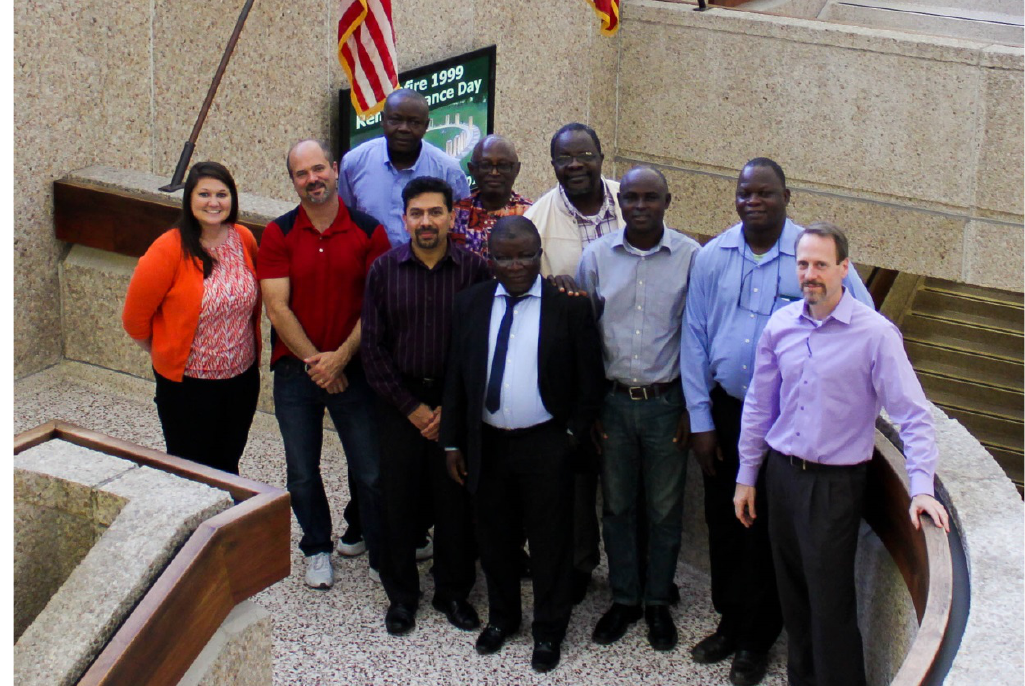
Figure 9. Nigerian faculty visit to Texas A&M in December 2014 for nuclear security curriculum